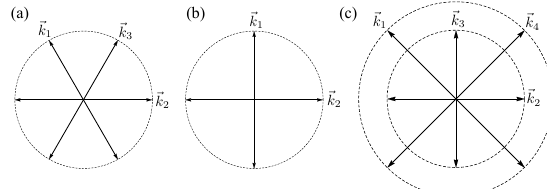
Fig. 3: Wavevectors for Fourier decompositions of (a) hexagon patterns (3) in which there is a triad of wavevectors satisfying (cid:126)k 1 + (cid:126)k 2 = (cid:126)k 3 , (b) square patterns (4), and (c) square patterns produced by a coupled pattern-forming system, in which there are overlapping triads of wavevectors satisfying (cid:126)k 1 + (cid:126)k (cid:126)k (cid:126)k (cid:126)k (cid:126)k 2 = 3 and 2 + 3 = 4